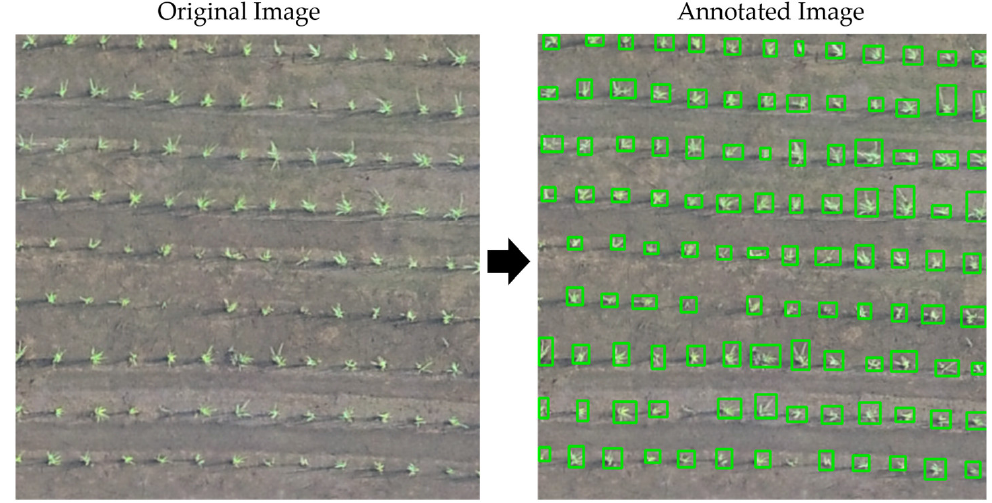
Figure 6. Rice seedlings annotated with bounding boxes in green on sub-images.